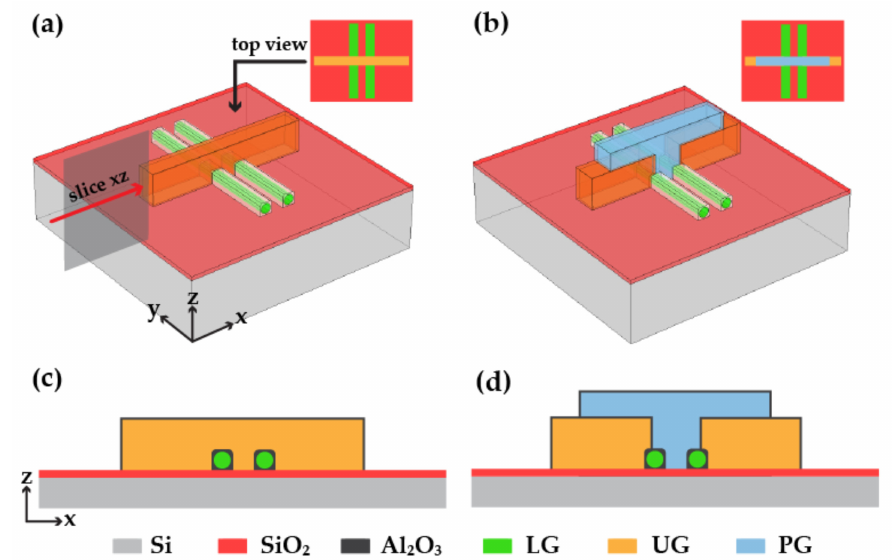
Figure 1. Modeled single quantum dot architectures. ( a ) Colored three dimensions (3D) and top views and ( c ) cross-section views of the non-tunable single quantum dot with only one upper gate (UG) used to define the quantum dot as well as the electron reservoirs. ( b ) Colored 3D and top views and ( d ) cross-section views of the tunable single quantum dot with the UG split in two to control the electron reservoirs while the plunger gate (PG) is used to independently define the quantum